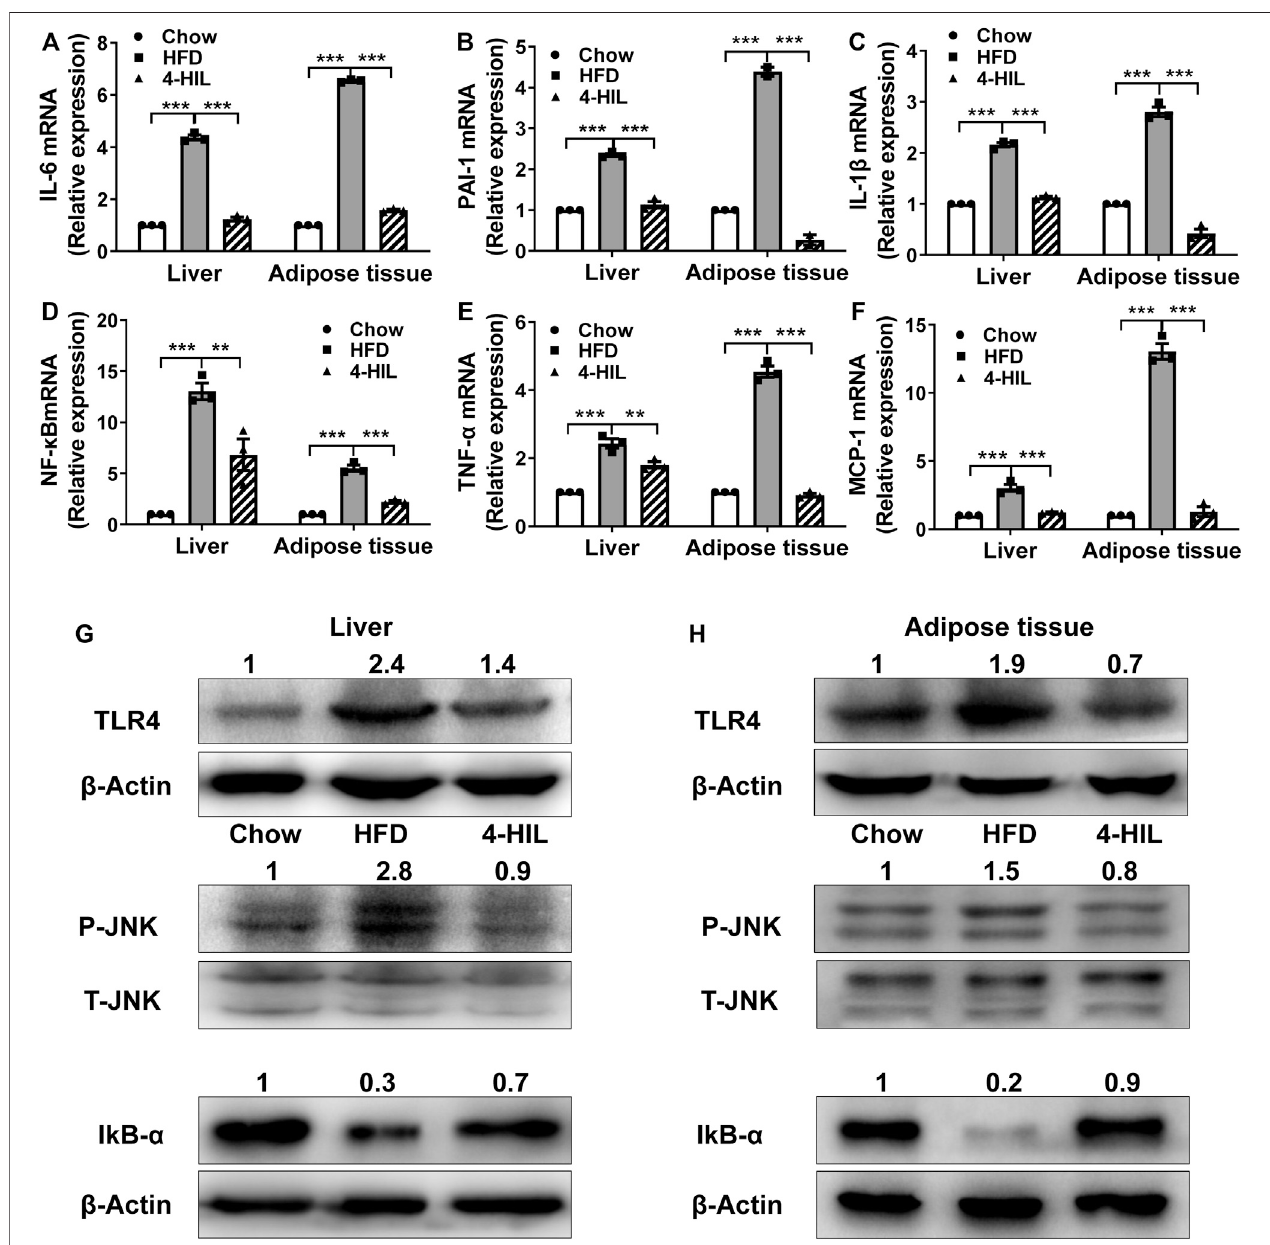
FIGURE 4 | 4-HIL decreases proin fl ammatory cytokine expression. After 8 weeks of 4-HIL (200 mg/kg)administration, the mRNA expression levels of IL-6 (A) , PAI-1 (B) , IL-1 β (C) , NF- κ B (D) , TNF- α (E) , and MCP-1 (F) in mouse liver and adipose tissues were detected by qRT-PCR. The relative level of mRNA was determined by comparing the relative expression of mRNA with that of the CHOW group by the Ct method. Effect of 4-HIL (200 mg/kg) on TLR4 related signaling pathway (G) – (H) . Representative immunoblotting of target proteins was used to detect the effects of 4-HIL treatment on TLR4 protein production, JNK phosphorylation and IkB- α production in liver and epididymal adipose tissues. *, 0.01 < p < 0.05; **, 0.001 < p < 0.01; ***, p < 0.001 ( n (cid:2) 3 for each group).